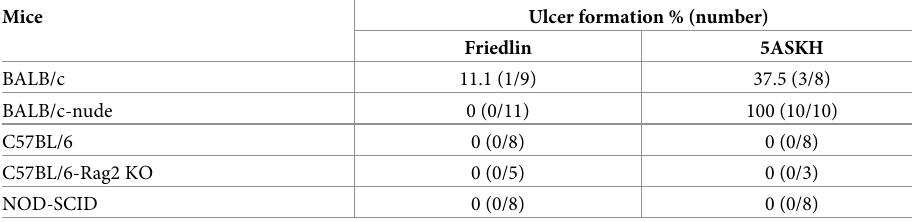
Table 1. Ulcer formation at 6 weeks post-infection with L . major Friedlin or